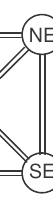
Figure 7. Layout for the example of criss-cross transport To keep the size of the problem within the possibilities of the student edition of AMPL , the transport related to the external platform is left out. The capacities of the four platforms are identical and invariant over time. The static data of the layout are summarised in table